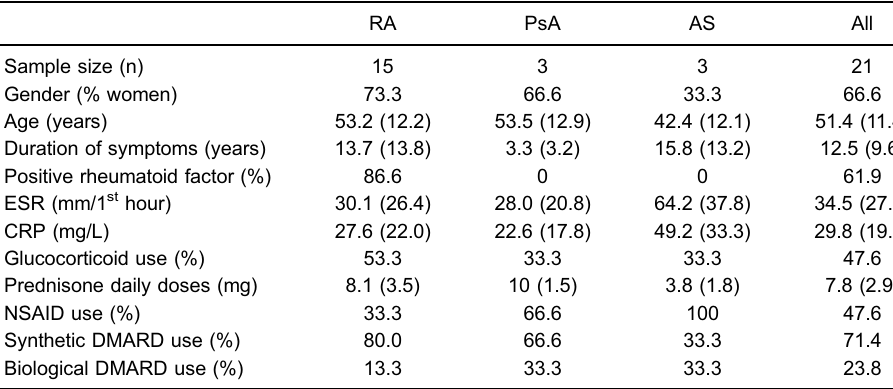
Table 1. Demographic and clinical data of patients with rheumatoid arthritis (RA), psoriatic arthritis (PsA), and ankylosing spondylitis